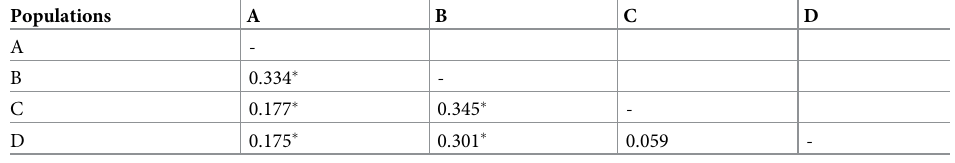
Table 4. Population pairwise F ST , between the 4 populations of Cryptozona siamensis in Thailand and Malaysia, based on the mitochondrial 16S rRNA gene sequences. Populations A